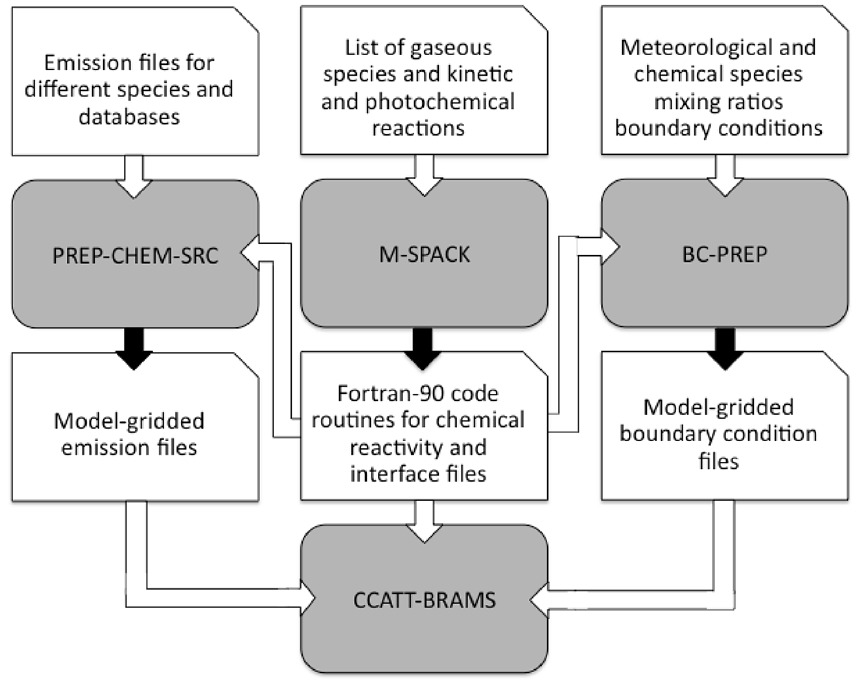
Figure 10. A chart of the BRAMS system with the CCATT chemistry model component. The gray blocks and the black arrows indicate the codes that make up the CCATT-BRAMS system and their outputs, respectively. The white blocks indicate either the input files for the pre-processing (first line) as the pre-processing outputs (third line), which are also input files for pre-processing emissions and boundary conditions and routines for composing the BRAMS model (adapted from Longo et al., 2013).